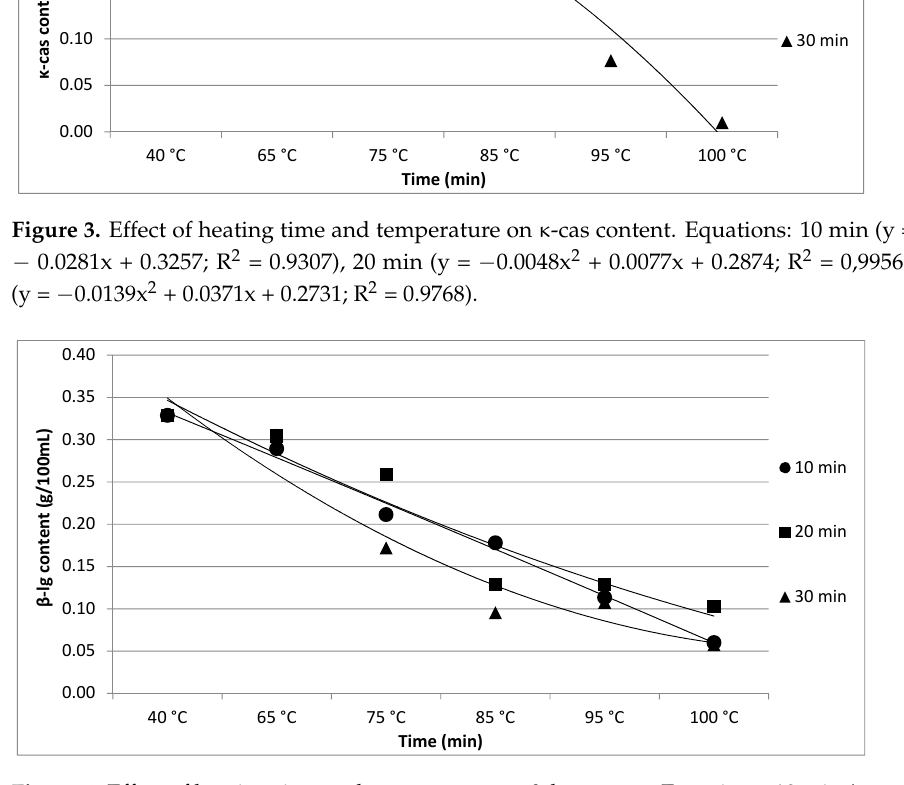
Figure 4. Effect of heating time and temperature on β -lg content. Equations: 10 min (y = − 0.0003x 2 – 0.0523x + 0.3845; R 2 = 0.9929), 20 min (y = 0.0031x 2 − 0.0725x + 0.416; R 2 = 0.9191), 30 min (y = 0.008x 2 − 0.1141x + 0.4553; R 2 = 0.935).